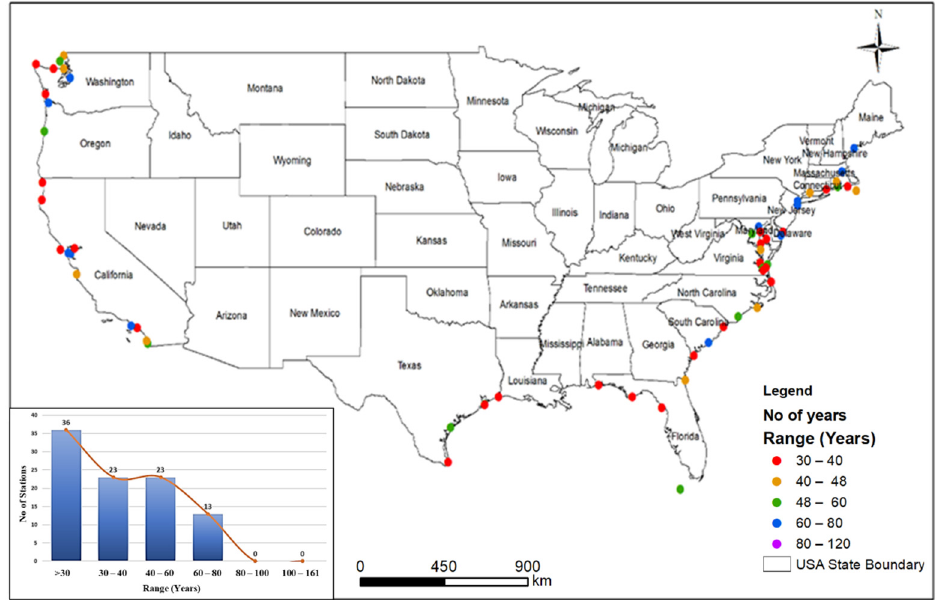
Figure 1. Distribution of the number of tide gage station long the US coast with varying record length.